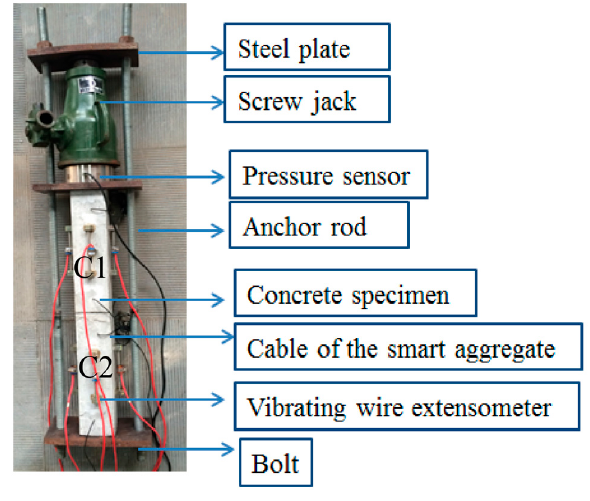
Figure 3. Loading device.